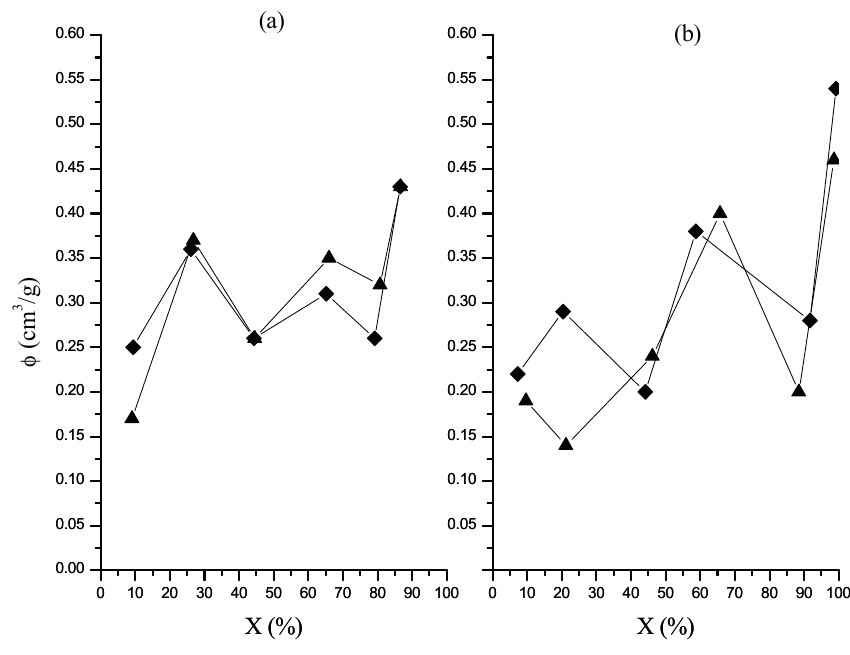
Figure 6. Evolution of nanoparticles porosity with global conversion in polymerizations at 0.05 ( a ) and 0.15 ( b ) g/min in organic phase dosing rate. Runs M ( ♦ ); runs MR ( ▲ ).